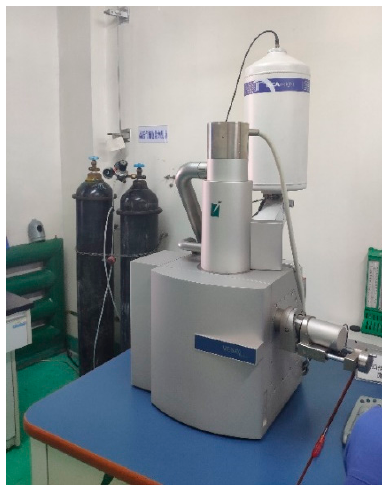
Figure 4. Scanning electron microscope.